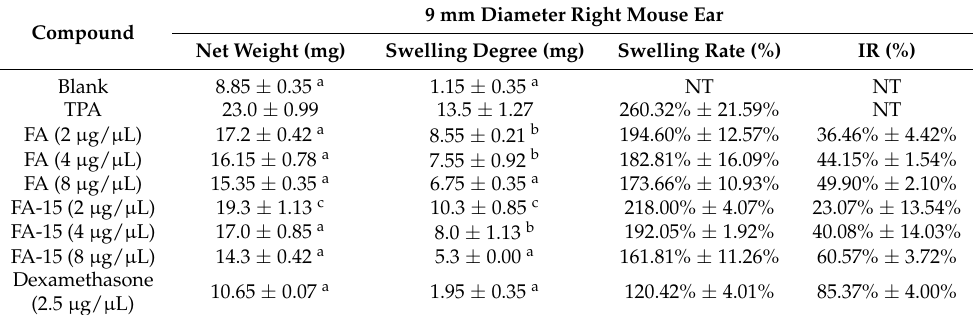
Table 3. Inhibition effects of FA and FA-15 in TPA-induced mouse-ear swelling experiment. 9 mm Diameter Right Mouse Ear Compound Net Weight (mg) Swelling Degree (mg) Swelling Rate (%)